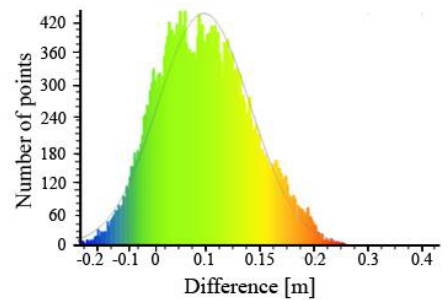
Figure 19. A graph showing a distribution of the cloud deviations of Test Area No. 2.